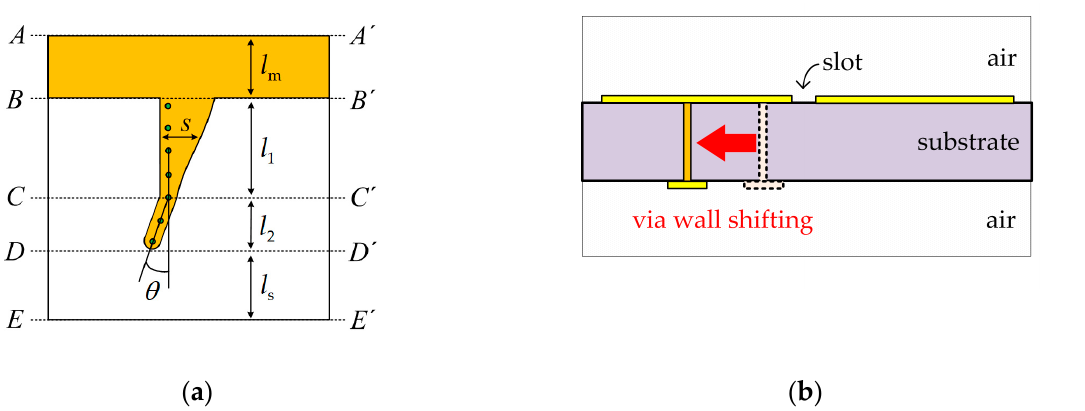
Figure 8. Via wall shifting in the CC ′ - DD ′ section: ( a ) bottom view; ( b ) side view.